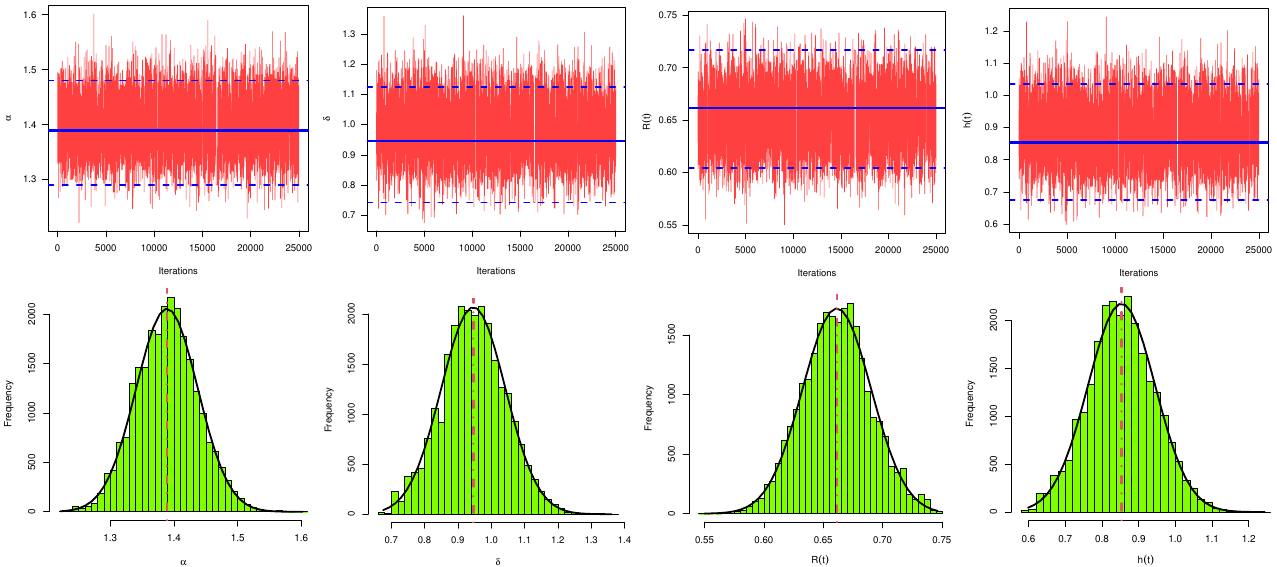
Figure 8. Trace (top-panel) and histograms (bottom-panel) plots of α , δ , R ( t ) , and h ( t ) from electrical appliances